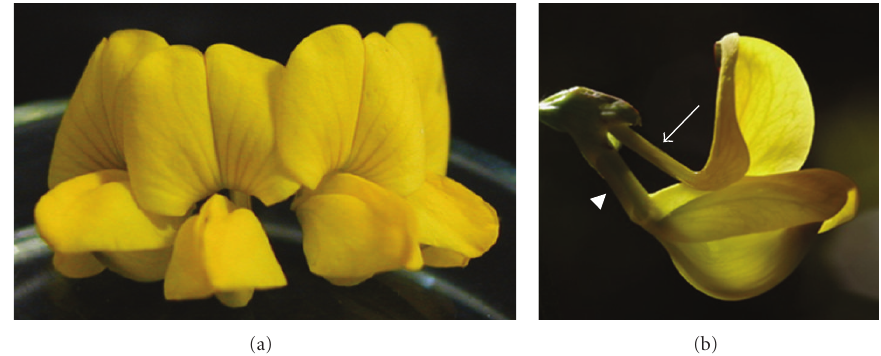
Figure 1: Flowers of C. emerus . (a) Front view of the flower with the wings-keel complex. Red nectar guides converging in the claw are evident on the standard petal. (b) Lateral view of the flower. The arrow indicates the standard claw. The arrowhead points to the cylindrical part of the keel.